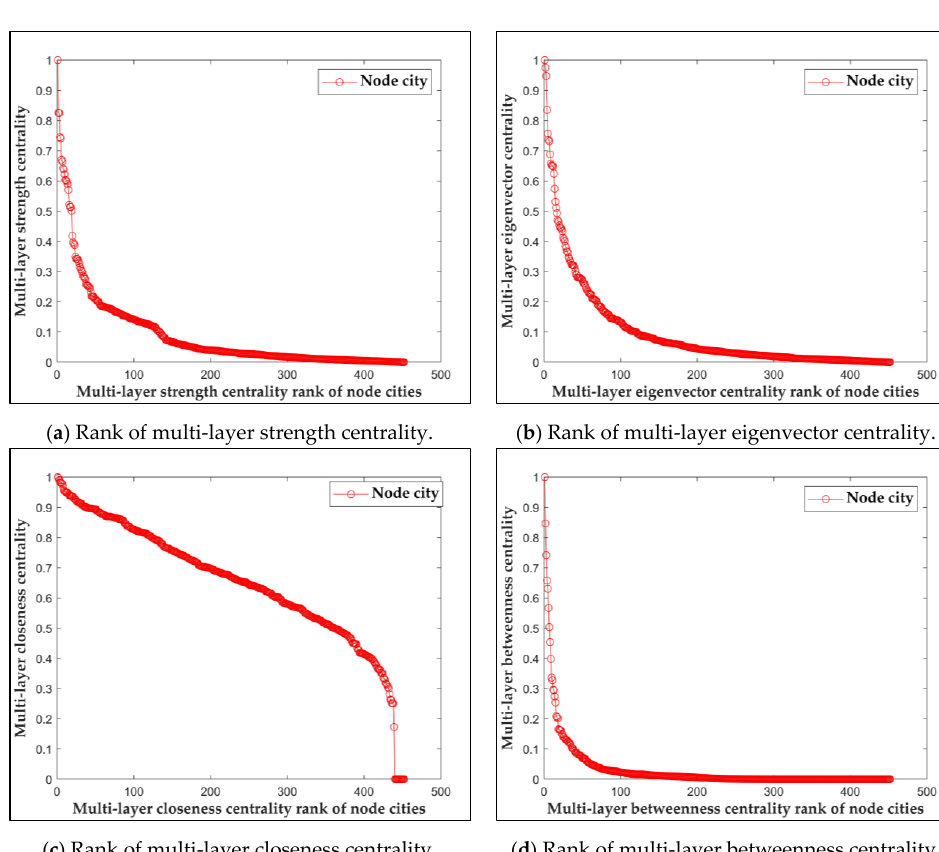
Figure 4. Rank of different multi-layer centrality of node cities.